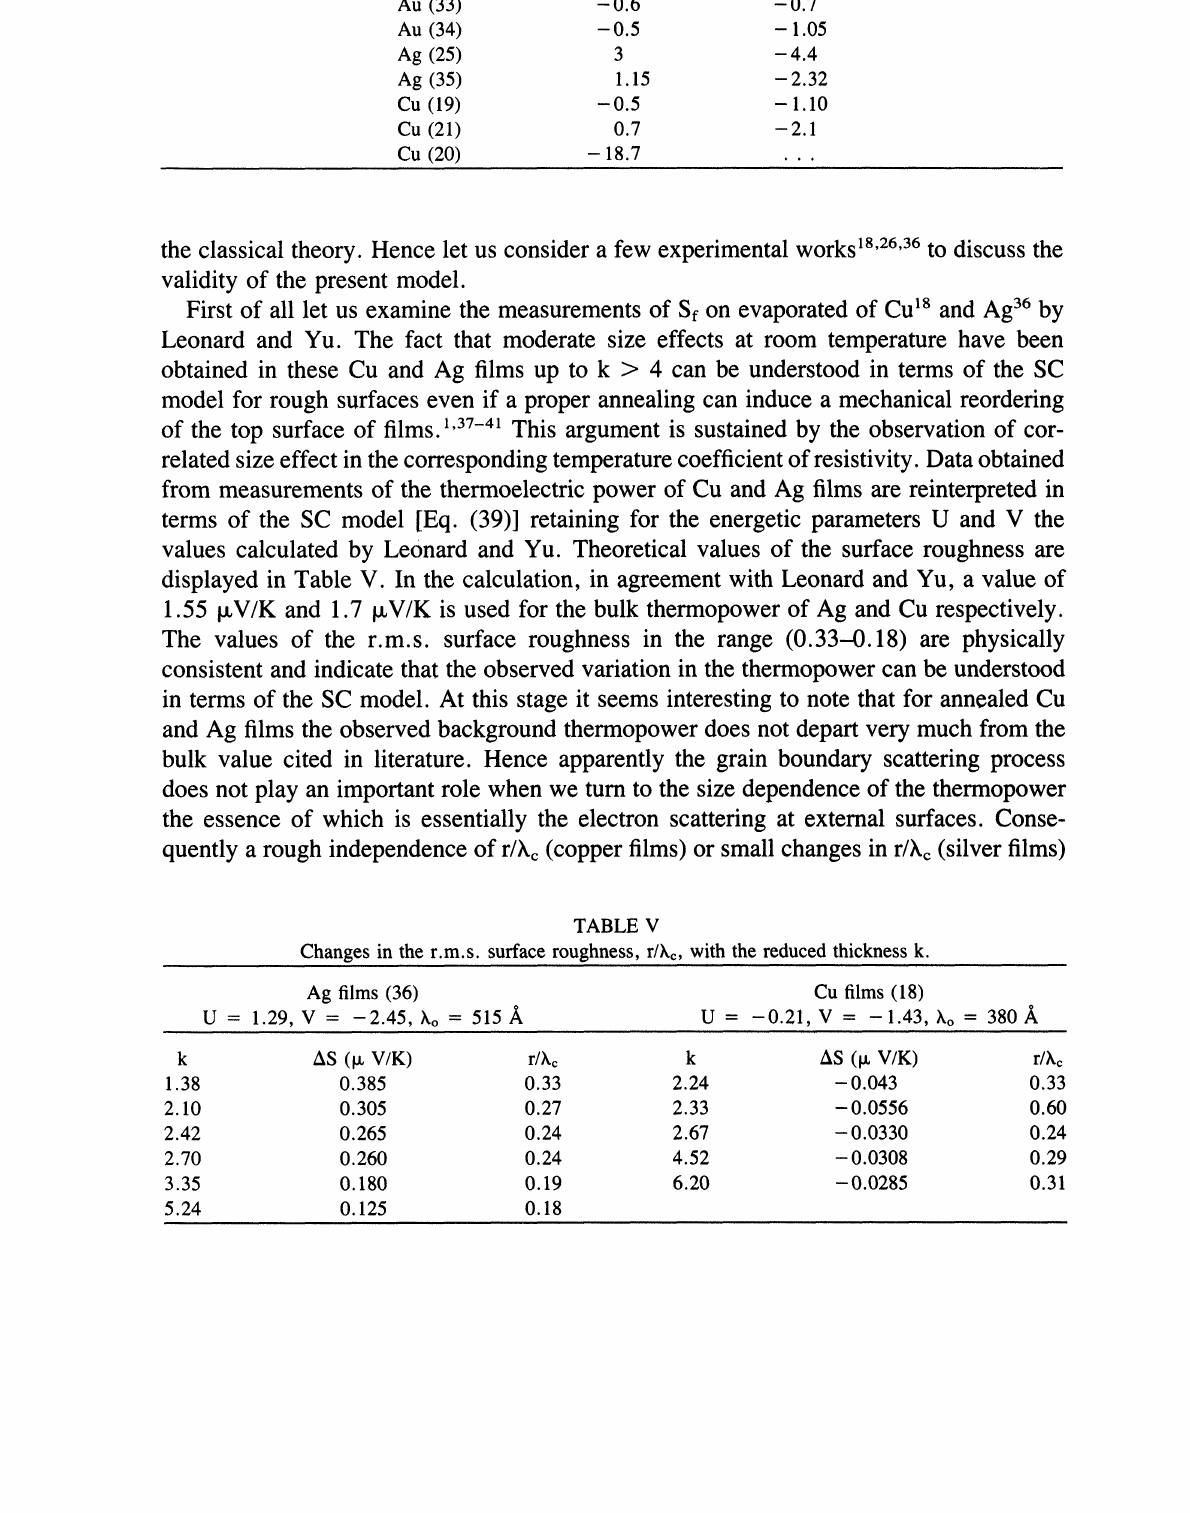
Energetic parameter data as determined from measurement of the thermopower on metal films.